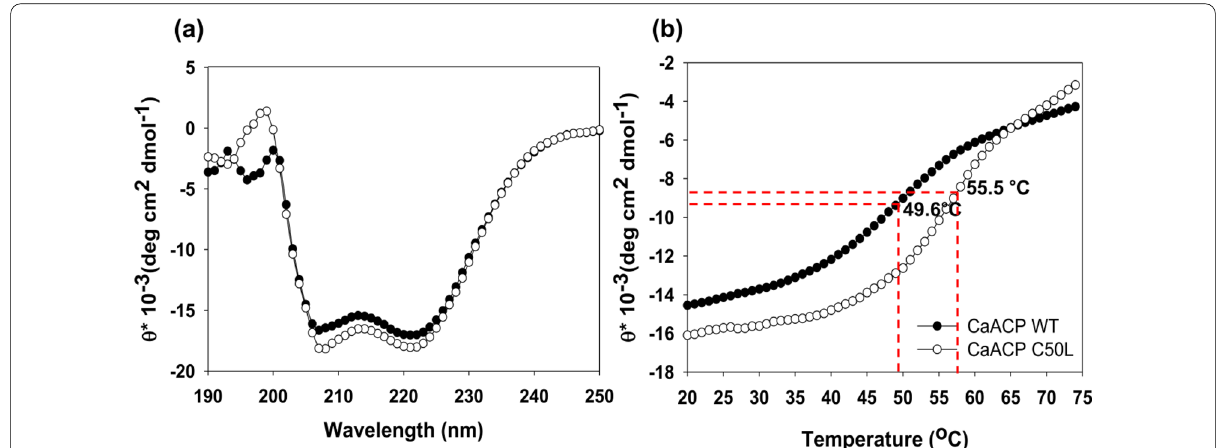
Fig. 2 The secondary structure and melting temperature of CaACP. a CD spectra of the CaACP WT and C50L mutant from 190 to 260 nm wavelength. b The melting curves of the WT and C50L mutant. All samples were in 25 mM Mes and 5 mM CaCl 2 buffer (pH